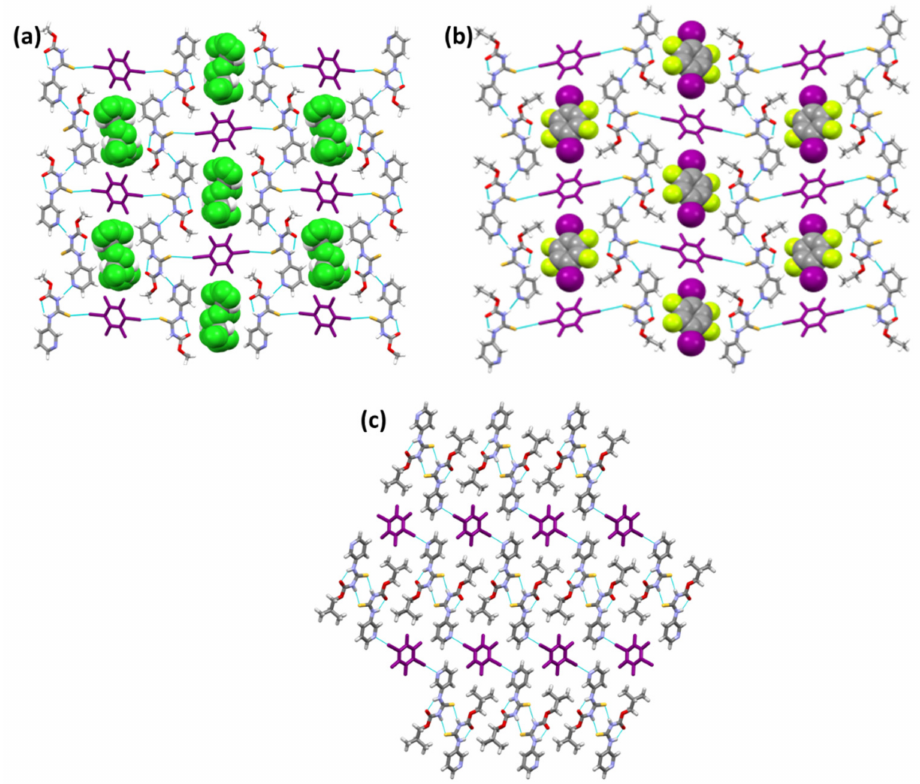
Figure 7. Crystal packing in the structures of ( a ) (A1) 2 · D2 , ( b ) A2 · D2, and ( c ) (A3) 2 ·